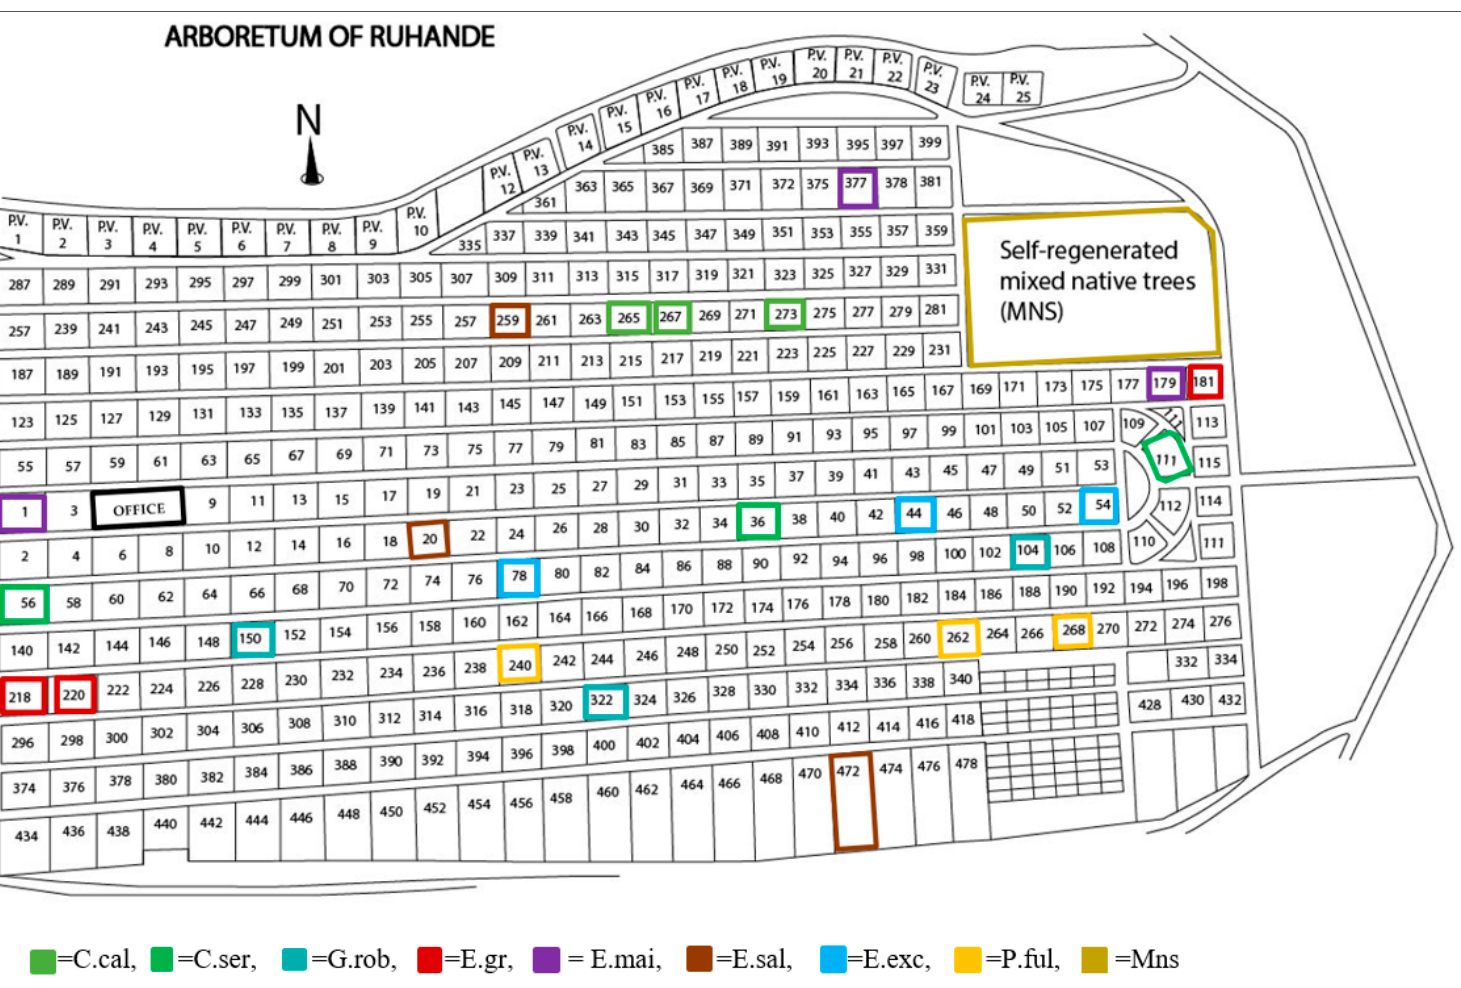
Figure 2. Map of the Arboretum of Ruhande, Rwanda. Studied plots are indicated in colors. More details can be found in Table A1. Adapted with permission from [52]. Copyright 1987 ISAR Foresterie.